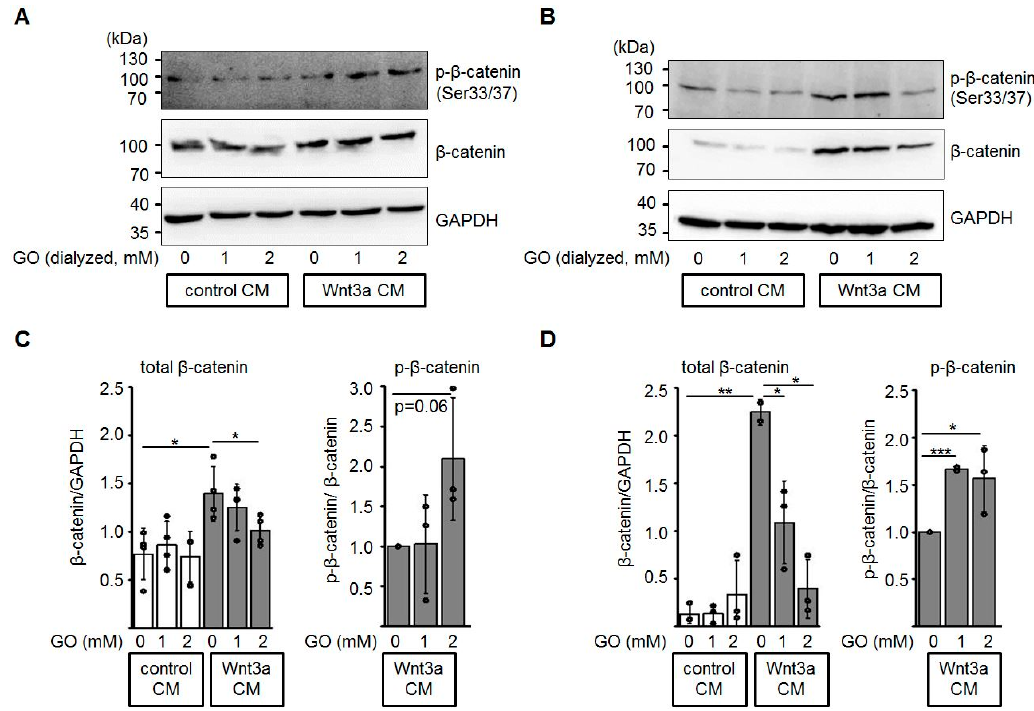
Figure 5. Glycation of Wnt3a CM affects total β -catenin and phospho- β -catenin levels. HEK-293 ( A , C ) and Neuro-2a ( B , D ) cells were treated with dialyzed conditioned medium for 12 h and cell lysates were subjected to SDS-PAGE and Western blotting as indicated. The presented blots are representatives of n ≥ 3 independent experiments. Circles represent individual experiments. * p < 0.05, ** p < 0.01, *** p < 0.001. Cells 2019 , 8 , 1320